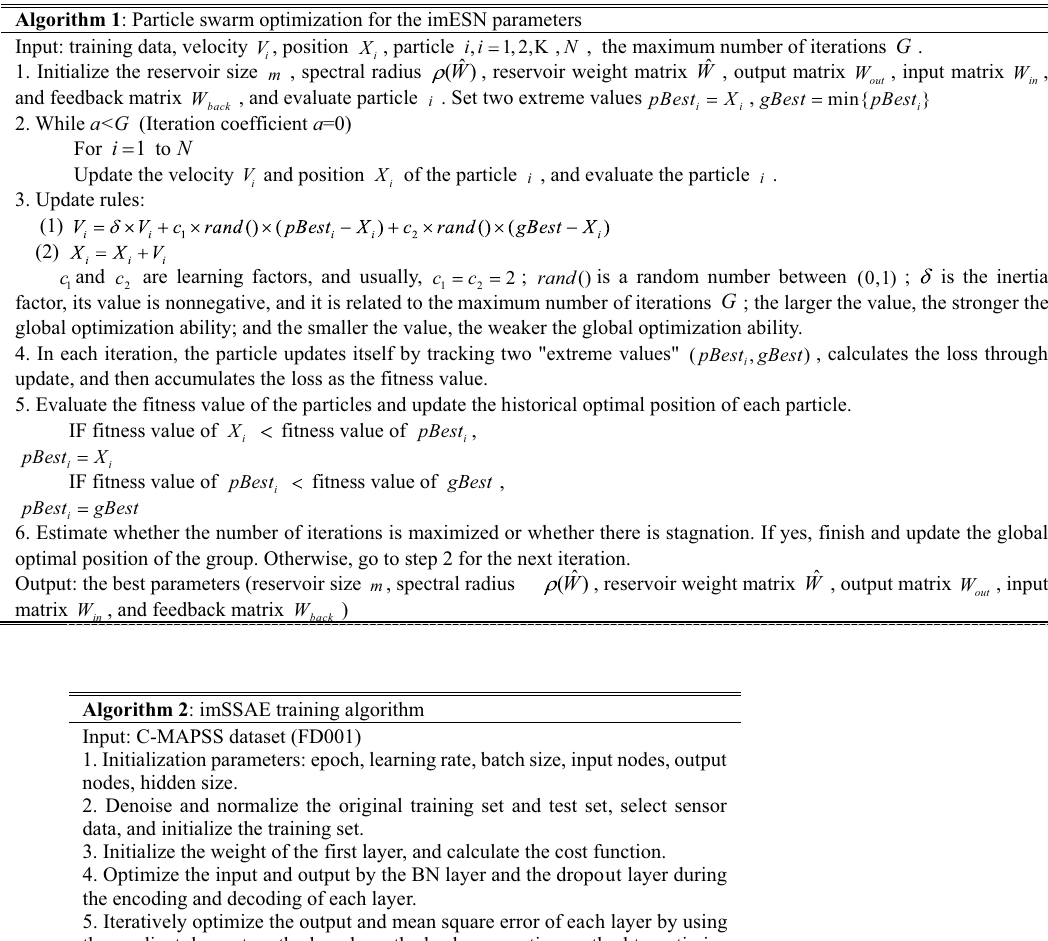
Algorithm 1 : Particle swarm optimization for the imESN parameters